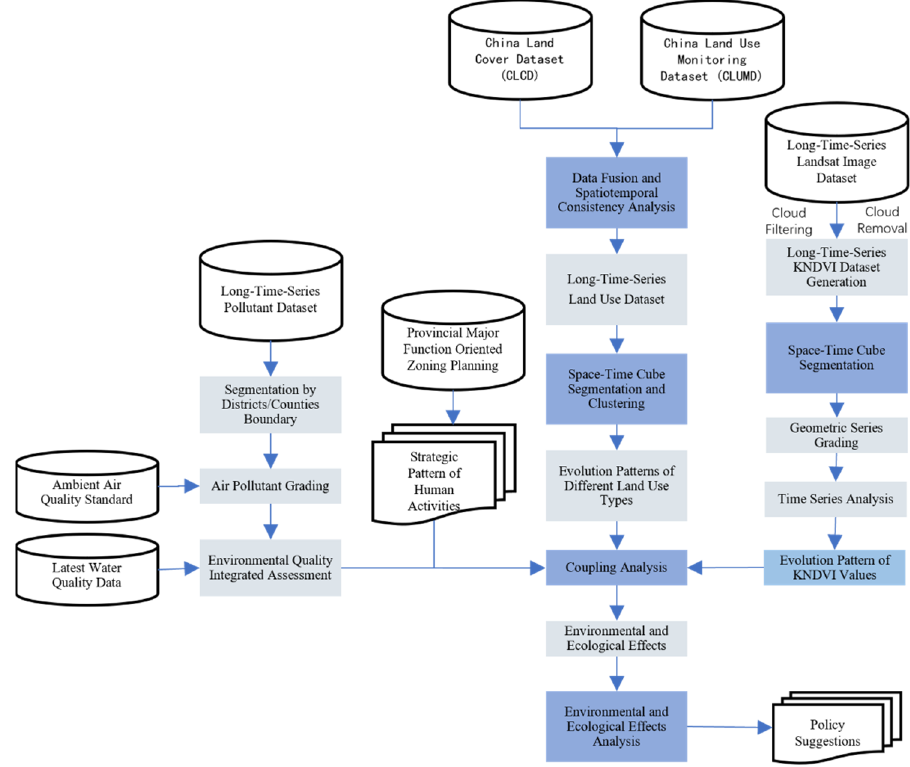
Figure 2. Overview framework of the methodology.